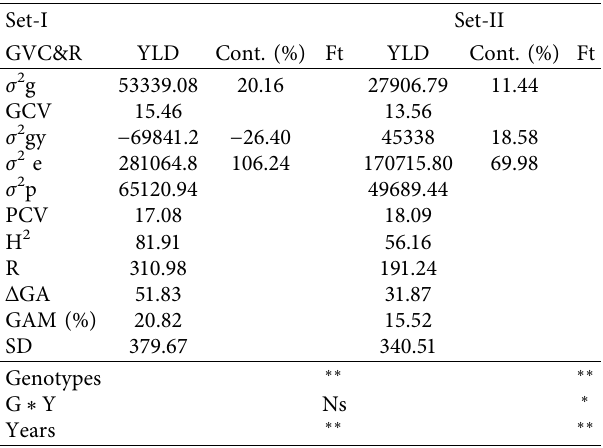
Figure 1: Repeatability of genetic gain trend and response to selection across coffee yield harvesting seasons for set-I and set-II. Table 7: Over year variance component, heritability, genetic gain and response to